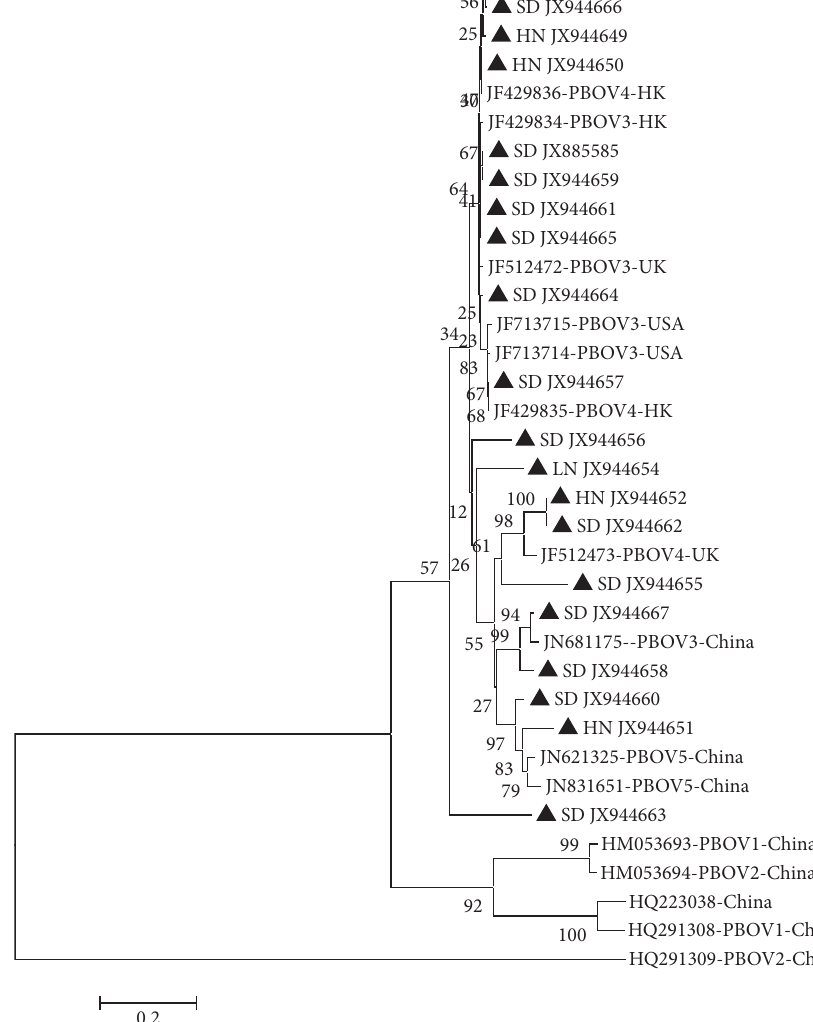
Figure 2: Phylogenetic tree constructed based on partial NS1 amino acid sequences of reference PBoV and PBoV from Chinese slaughter pigs. Slaughter pig sequences are labeled with 󳵳 and their corresponding accession numbers. The phylogenetic tree was constructed by MEGA ver. 5.1 with neighbor-joining method using 1,000 bootstrap